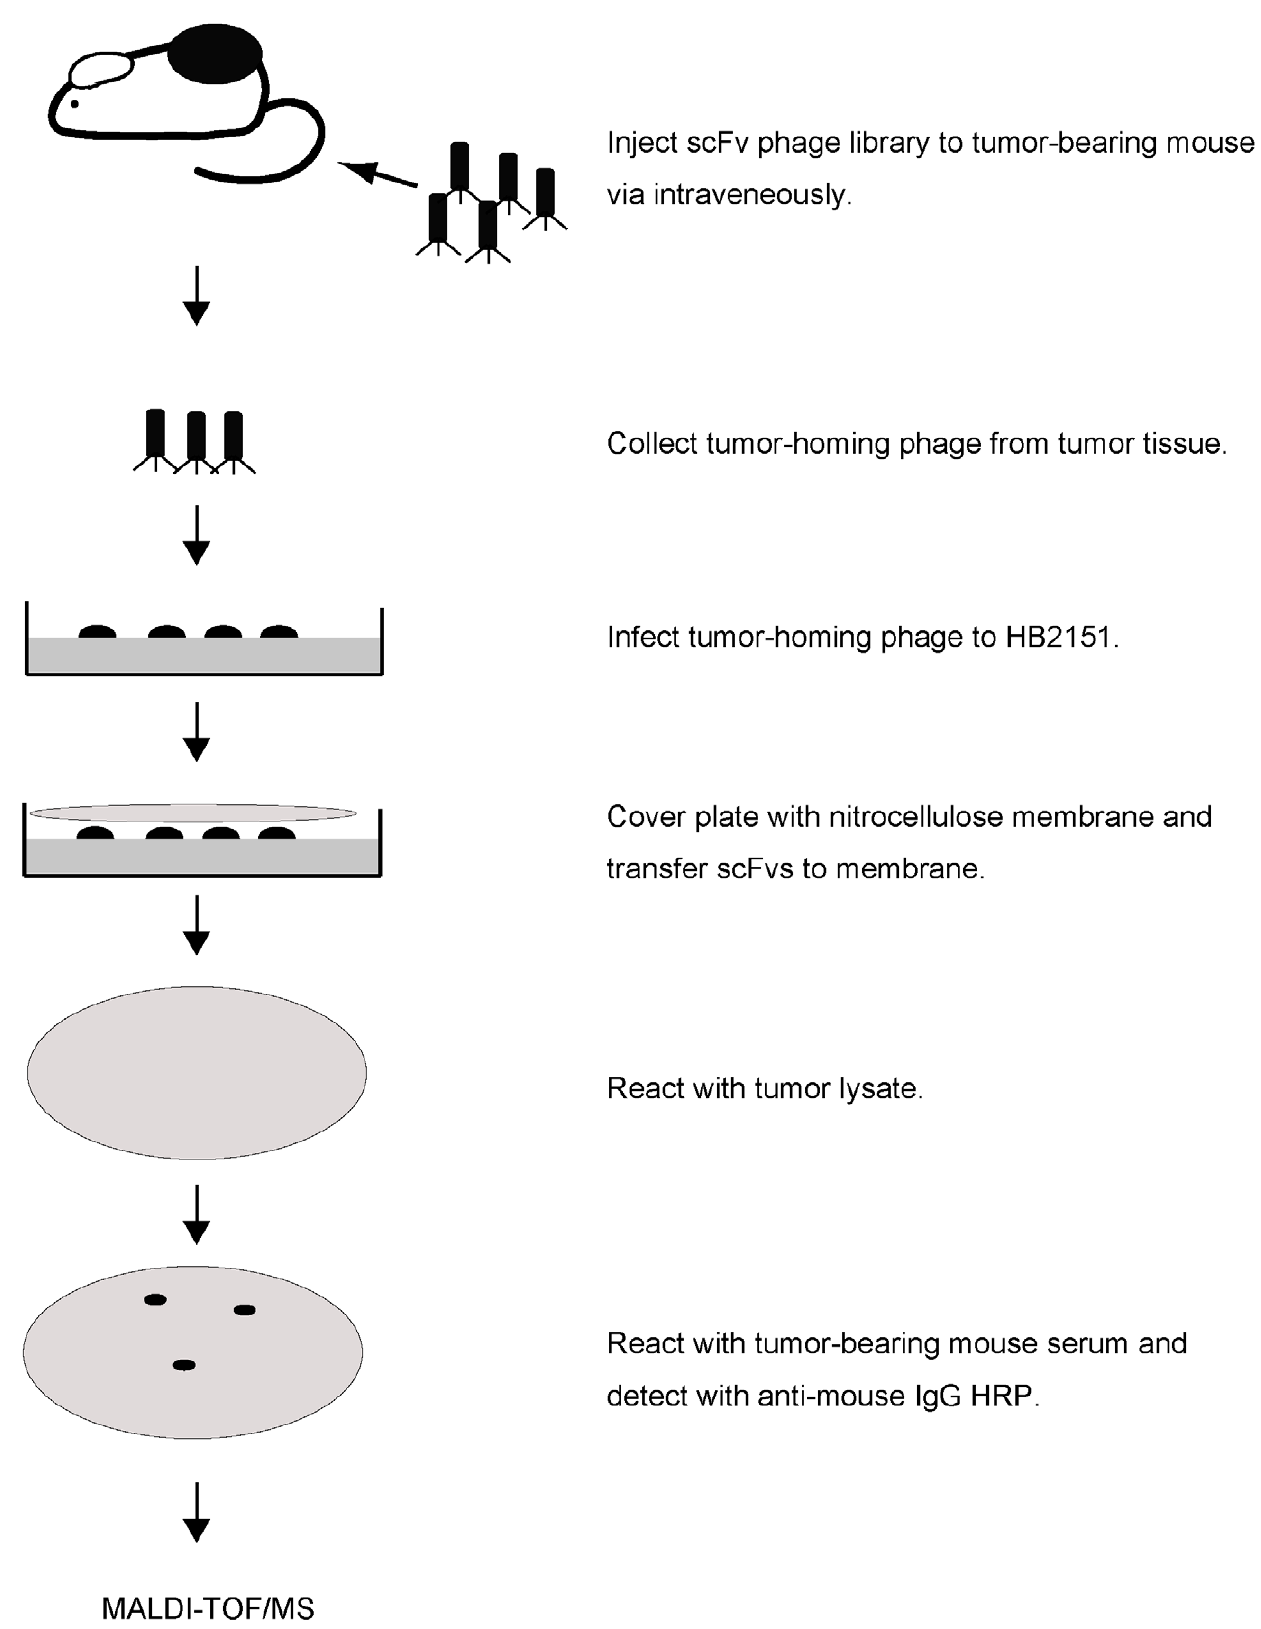
Figure 1. Overview of the rapid method for isolating auto-antibody against tumor-associated antigen (TAA) using a scFv library. The tumor-homing scFv-presenting phages were collected from tumors that were injected with a scFv library. The collected phages were infected to